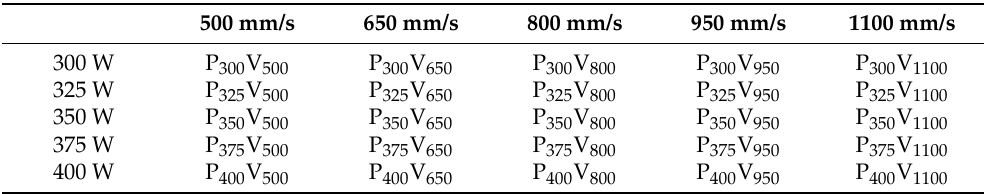
Table 2. Sample number and corresponding laser power and scanning